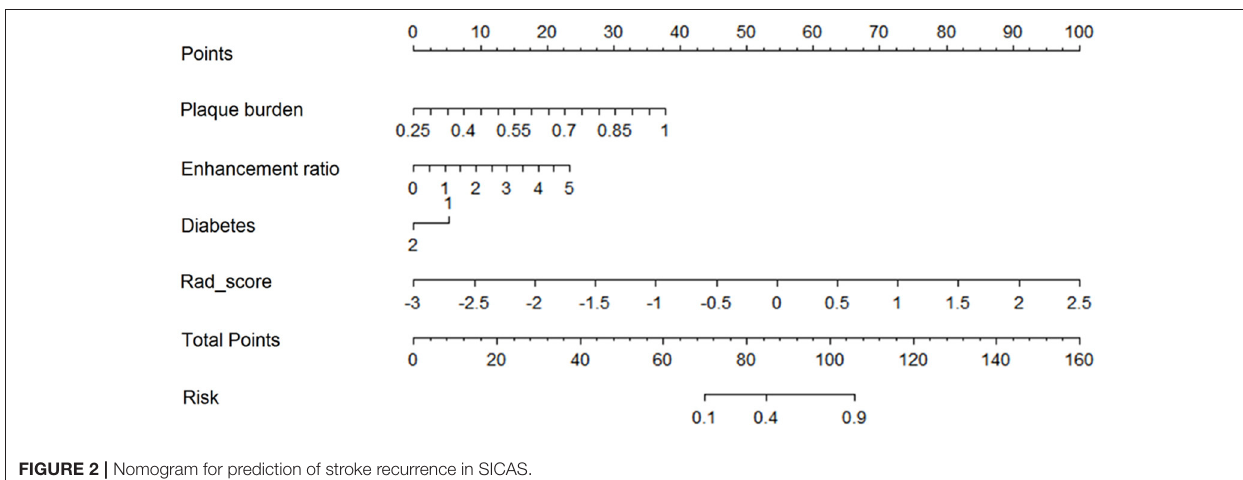
FIGURE 2 | Nomogram for prediction of stroke recurrence in SICAS.